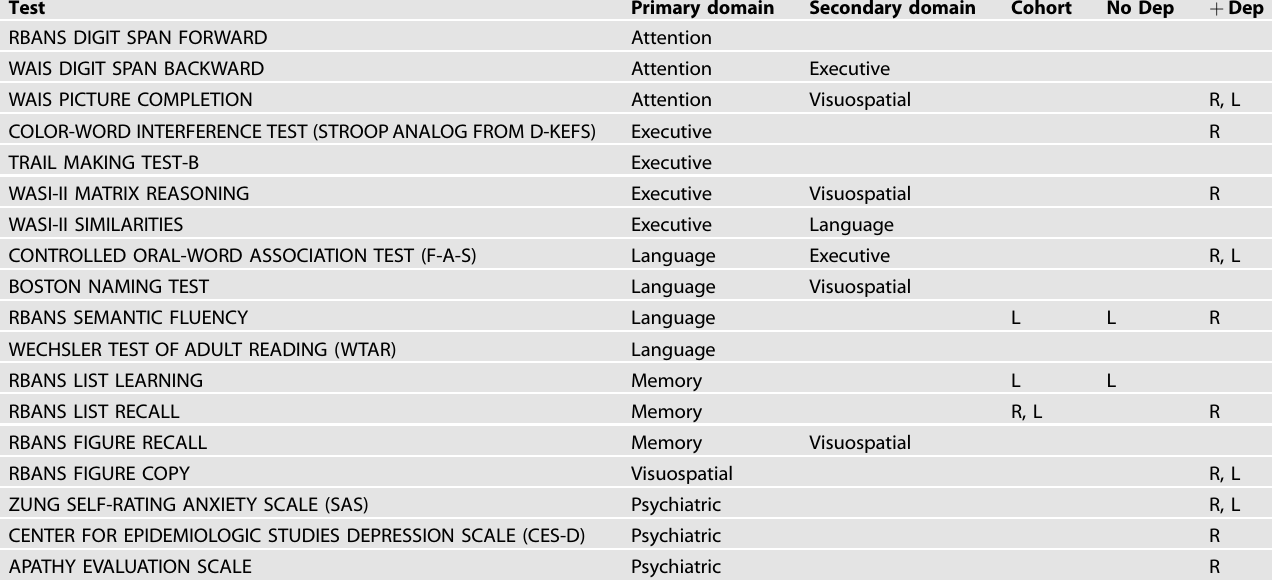
Table 2. Neuropsychological tests administered and statistically signi fi cant results for entire cohort and subcohorts based on depression